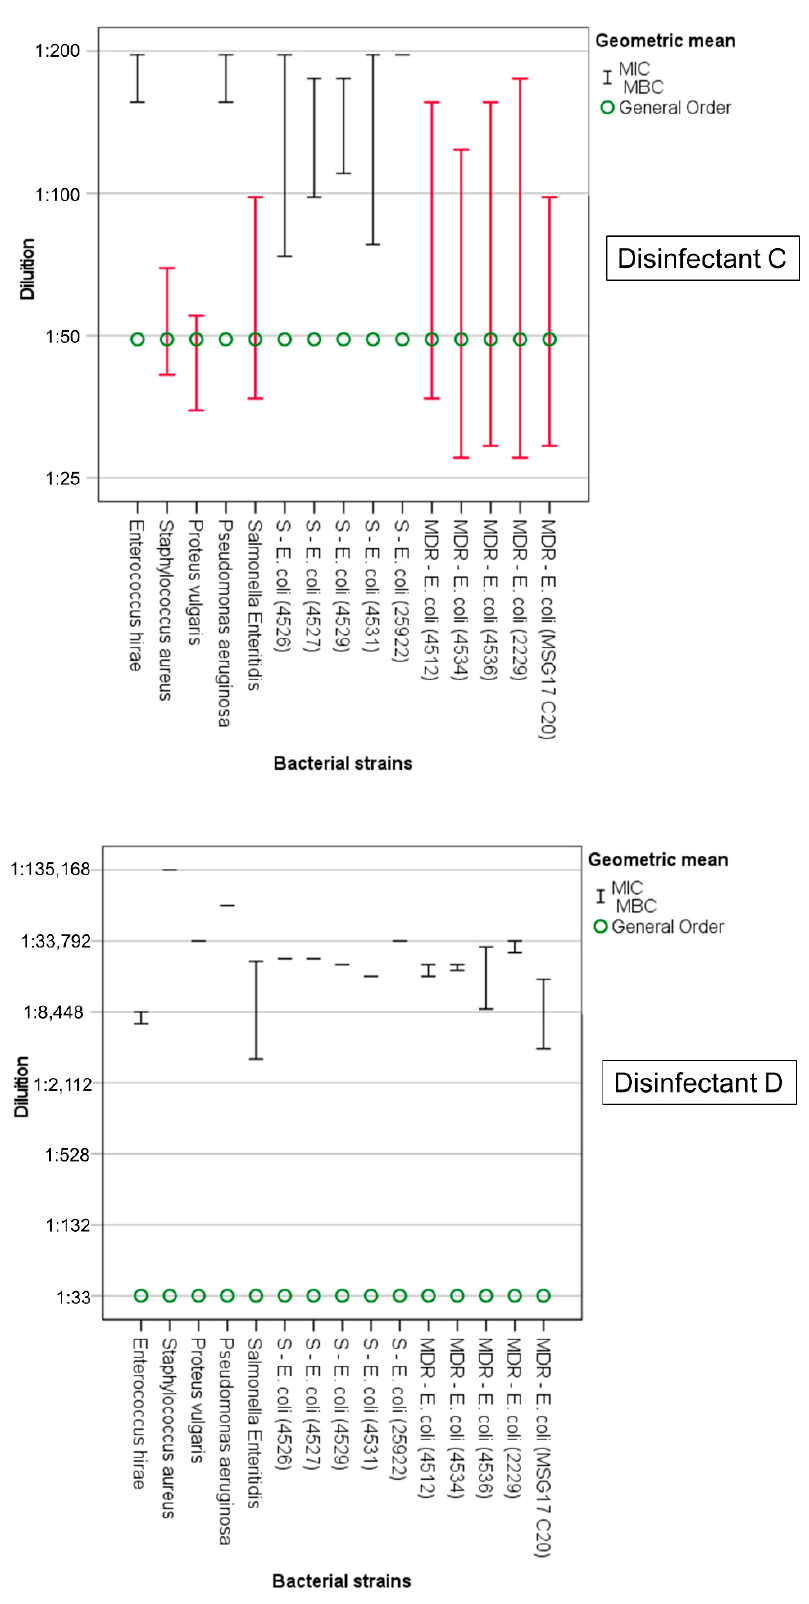
Figure 2. Disinfectant C and disinfectant D. Minimum inhibitory concentration (MIC, upper whisker) and minimum bactericidal concentration (MBC, lower whisker). In red, bacterial strains tolerant to disinfectants (MBC > GO).